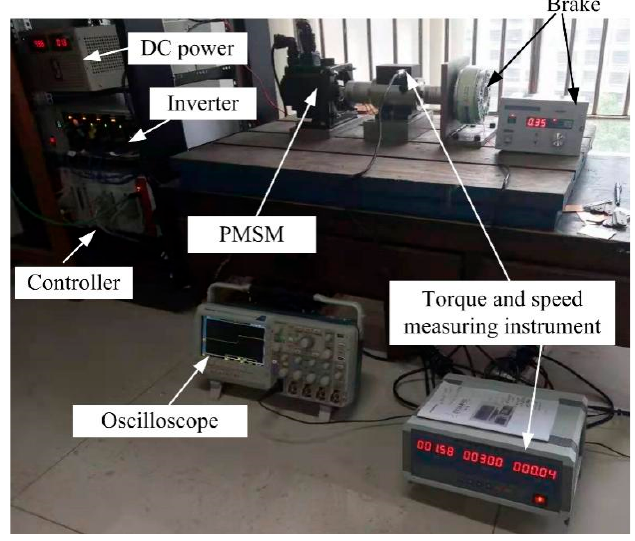
Figure 6. Experimental test platform.